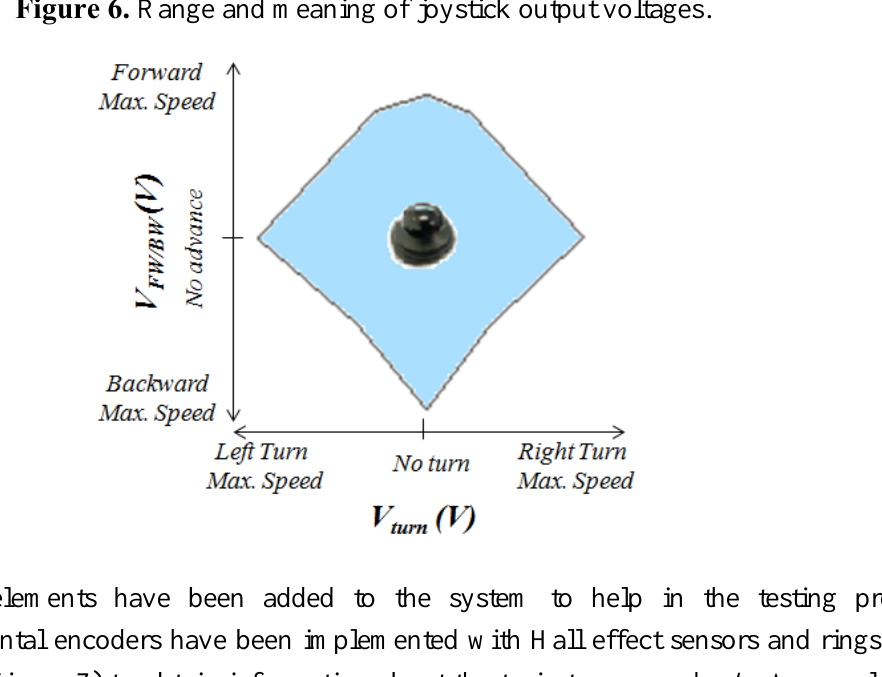
Figure 6. Range and meaning of joystick output